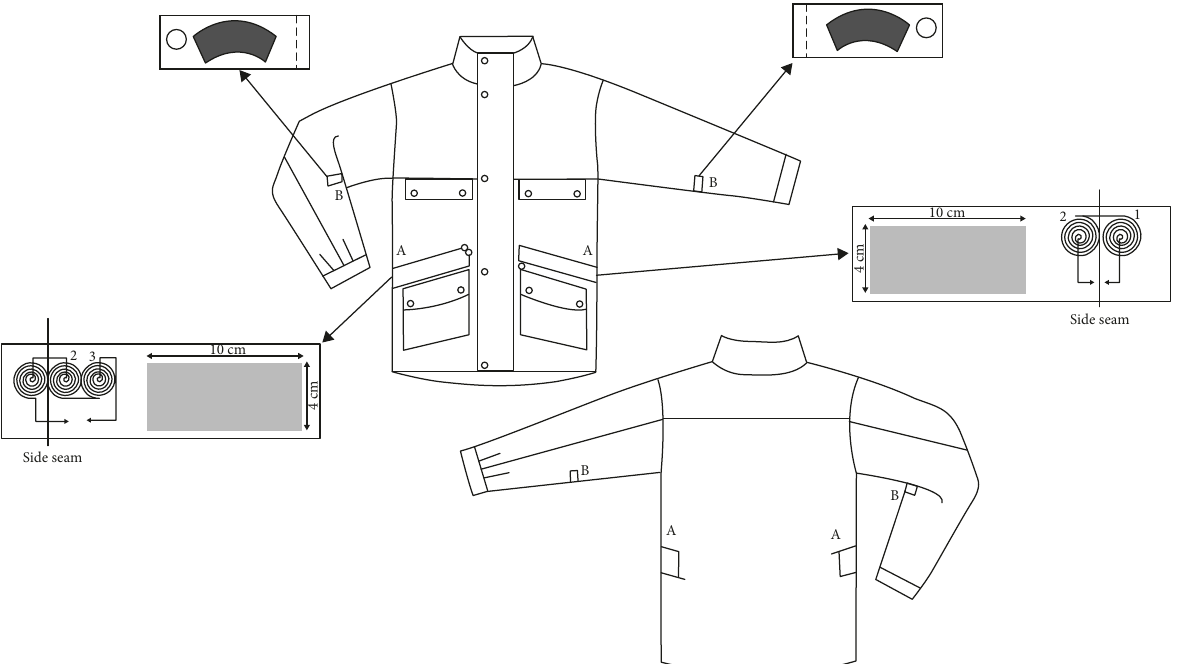
Figure 5: A technical drawing of the jacket with an indication of placement of the individual elements of the electromagnetic generator. A: location of the coil and accumulator; B: location of the permanent magnet (reproduced from Eglite et al. [20], under the Creative Commons Attribution License/public